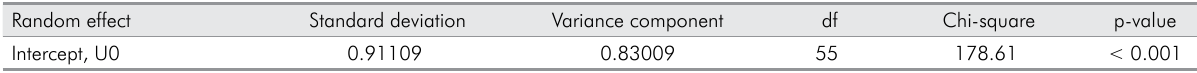
Table 3. Final estimation of variance components in the multilevel analysis – “null